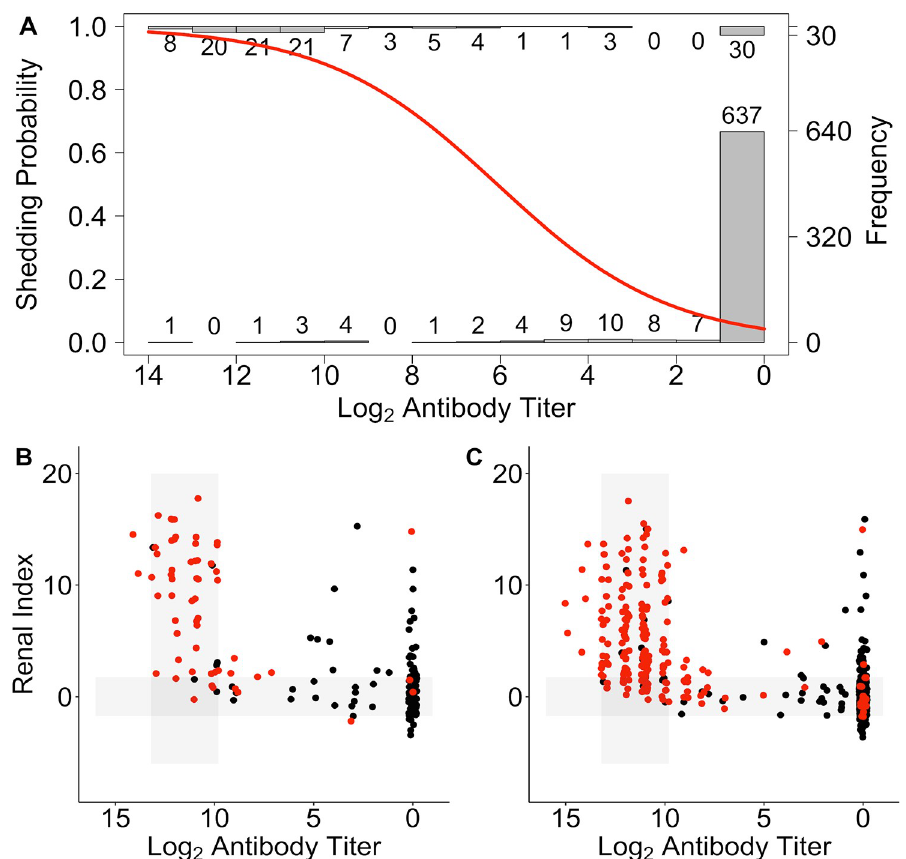
Fig 8. Shedding probability predicted from log 2 anti- Leptospira antibody titer. (A) The probability of shedding as a function of log 2 anti- Leptospira antibody titer plotted over histograms of the number of animals shedding (top histogram) and not shedding (bottom histogram) by antibody titer (A). STRAND data plotted using the ‘host- pathogen map’ framework as in Fig 4C. Data divided into those individuals that were PCR tested and for which shedding status was known (B), and those that were not PCR tested and for which shedding status was predicted (C; positive = red, negative =